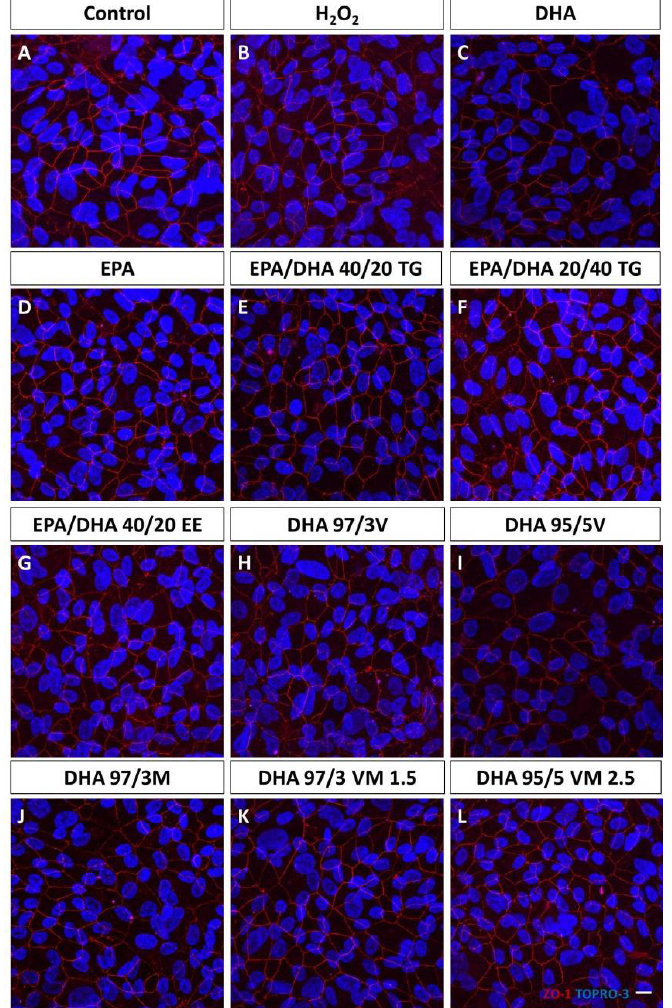
Figure 1. Effect of omega-3 supplements on epithelial tight junctions. ZO-1 (red) immunofluorescence were not affected by any of the omega-3 treatments. Nuclei are stained with TOPRO-3. Scale bar 20 µm. ( A ): Control group; ( B ): H 2 O 2 treatment group; ( C ): DHA (Docosahexaenoic acid) group; ( D ): EPA (Eicosapentaenoic acid) group; ( E ): EPA/DHA 40/20 ;TG (Triglycerides) group; ( F ): EPA/DHA 20/40 TG group; ( G ): EPA/DHA 40/20 EE (Ethylesters) group; ( H ): DHA 97/3V(Vegetable) group; ( I ):